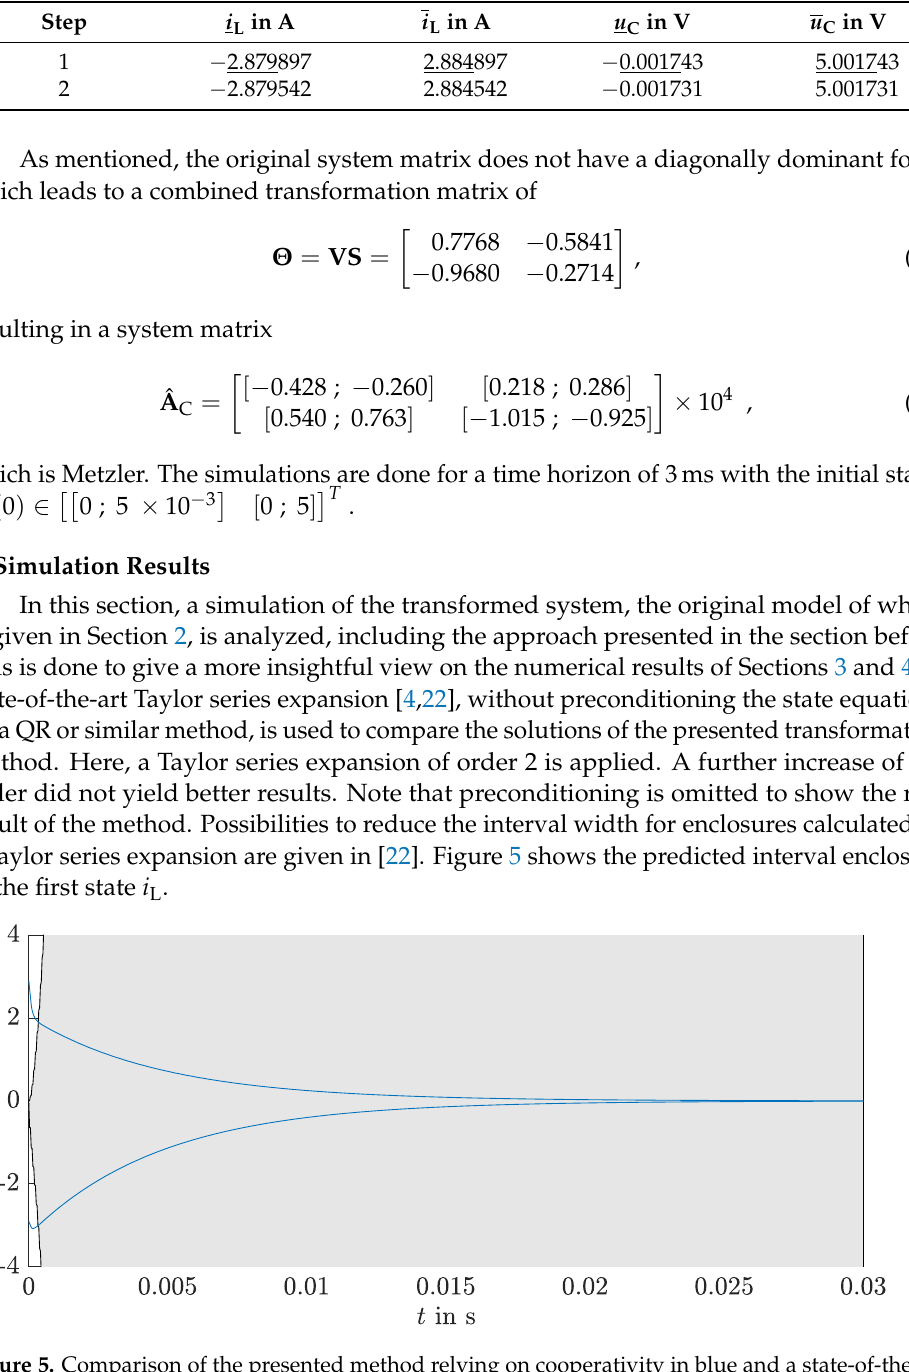
Table 2. Hulls of interval enclosures over the whole time horizon of 3ms.